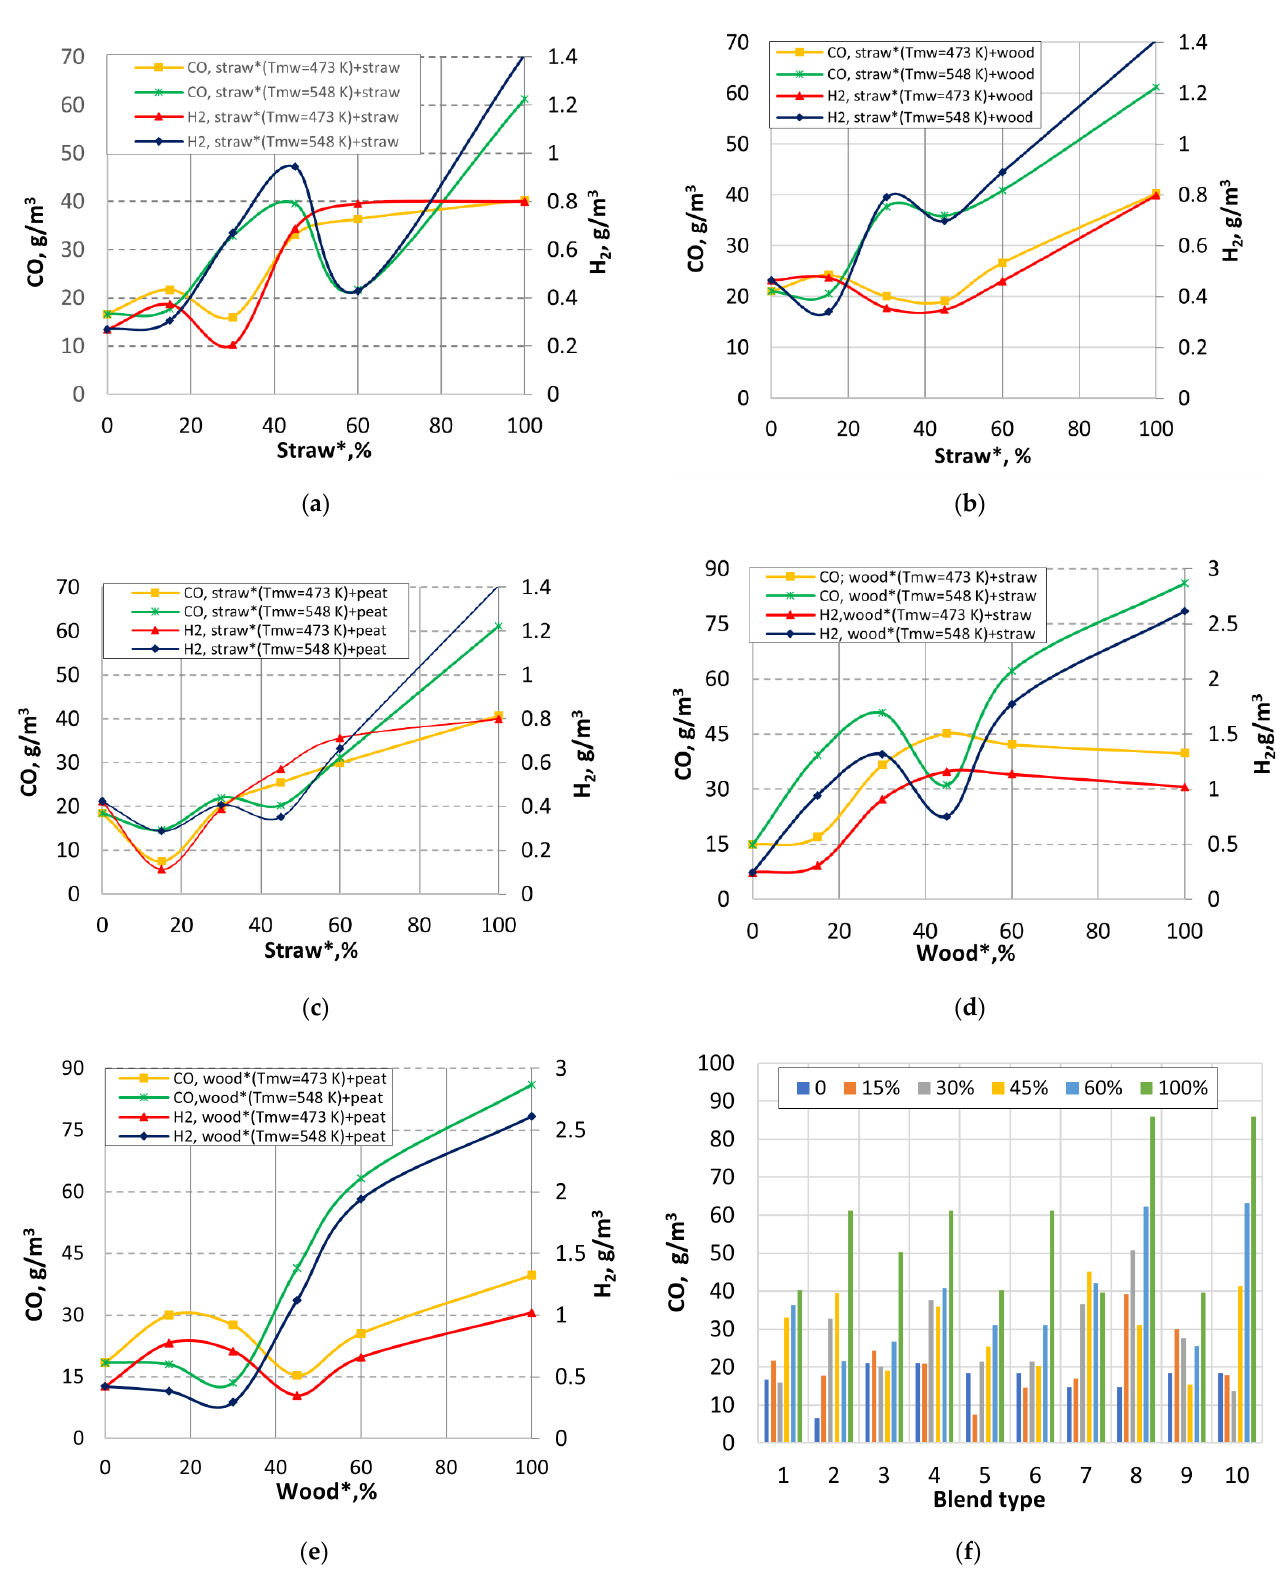
Figure 5. The effect of MW pre-treatment temperature and mass fraction of pre-treated pellets in the blend on the yield of combustible volatiles (CO, H 2 ) ( a – e ) and summary of the yield of CO all blends ( f ) (for composition of blends see Figure 4).